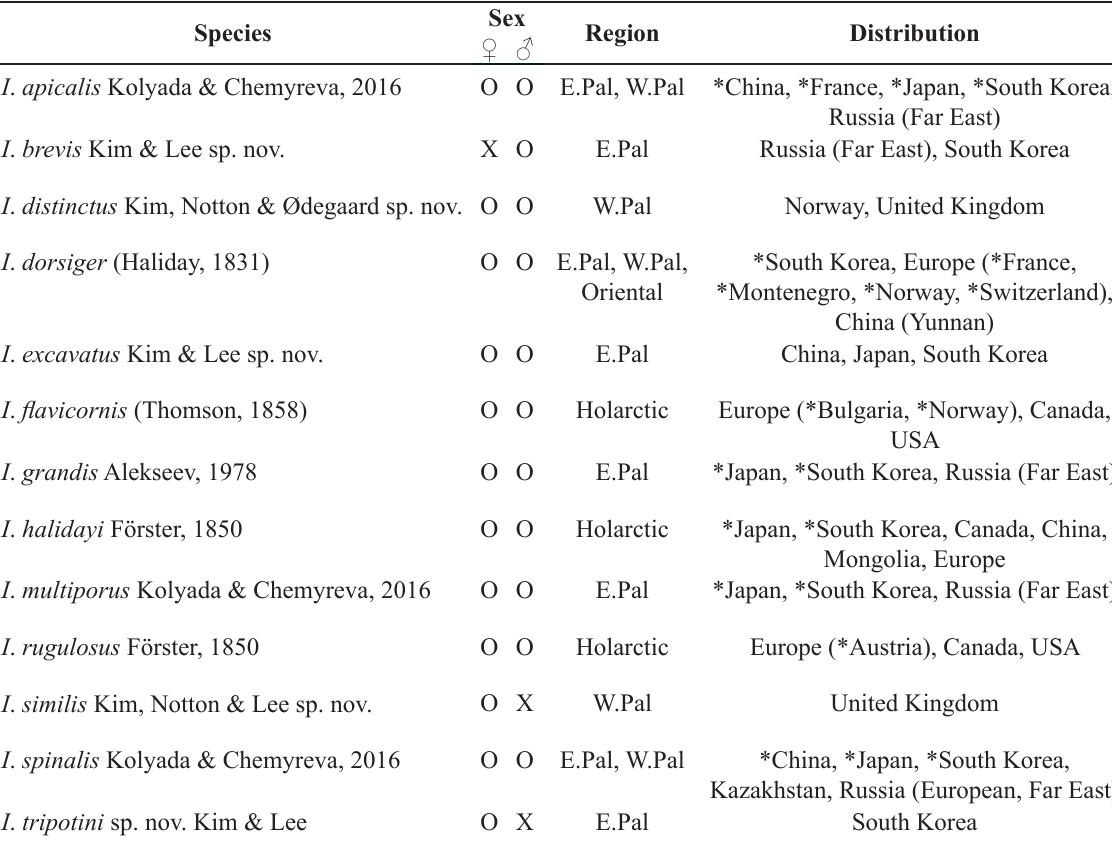
Table 1. An overview of Palaearctic species of Ismarus Haliday, 1835. Abbreviations: E.Pal = Eastern Palaearctic; W.Pal = Western Palaearctic; * = new country record; O = known; X